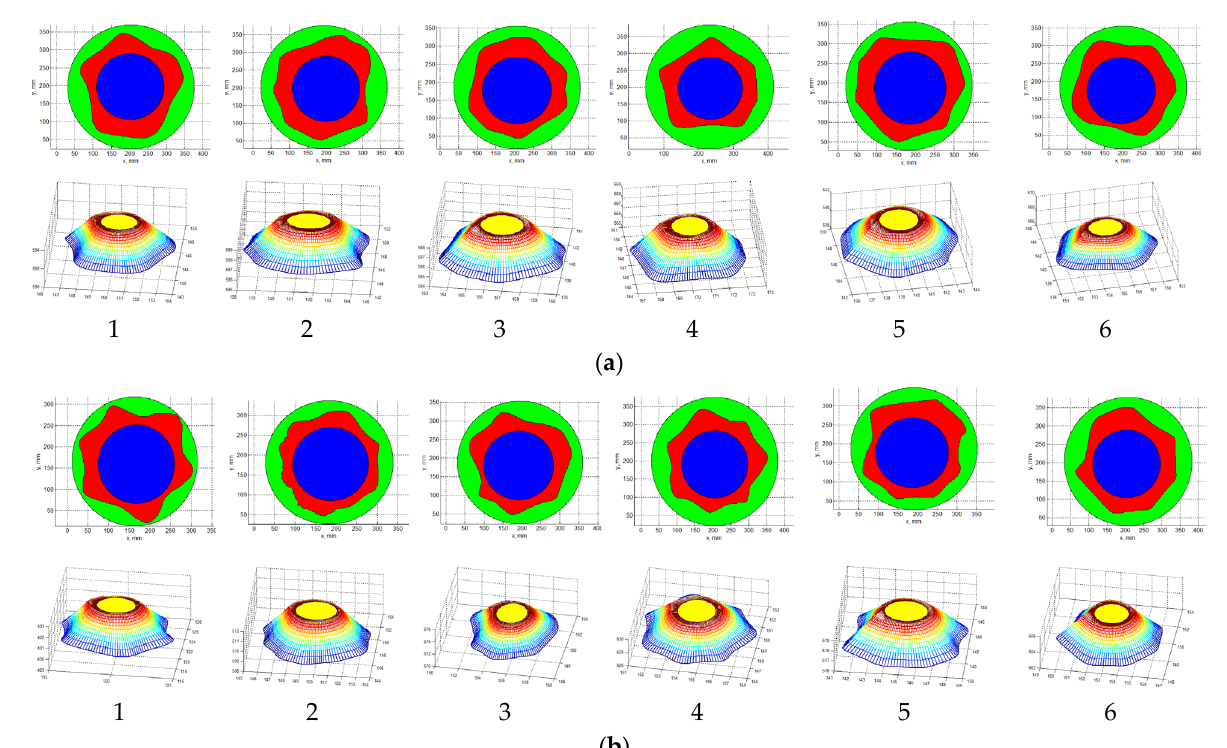
Figure 10. The 3D representation of the drape. ( a ) Without printing; ( b ) with 3D printed geometries. Description: Red, Drape; Green, Paper disk; Blue, Supporting disk. The color changes of 3D variants are according to the height of the drape.